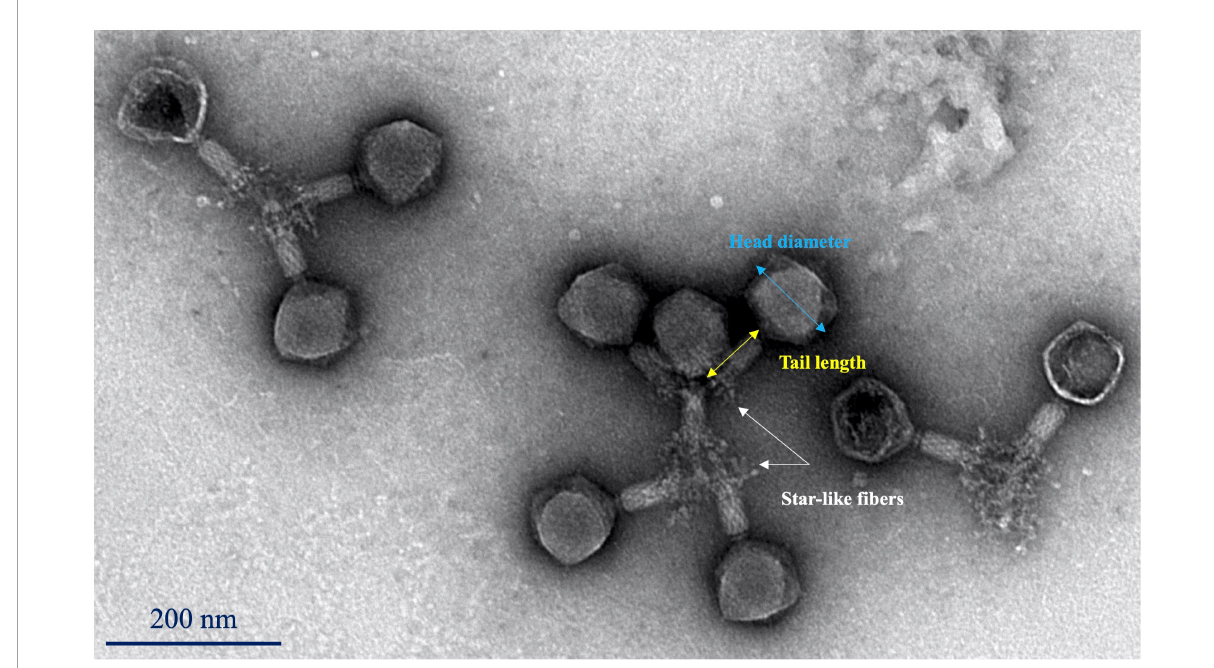
FIGURE4 Transmission electron microscopy image of phage Sa157lw with an icosahedral capsid (99 ± 3 nm in diameter) and a contractile tail (87 ± 3 nm in